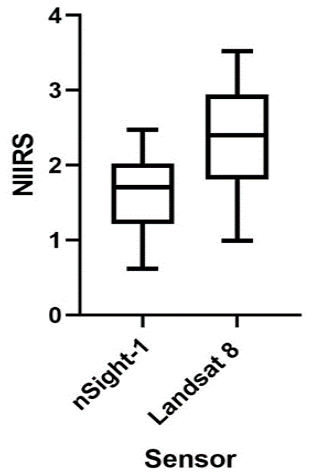
Figure 4. NIIRS box and whisker plot.